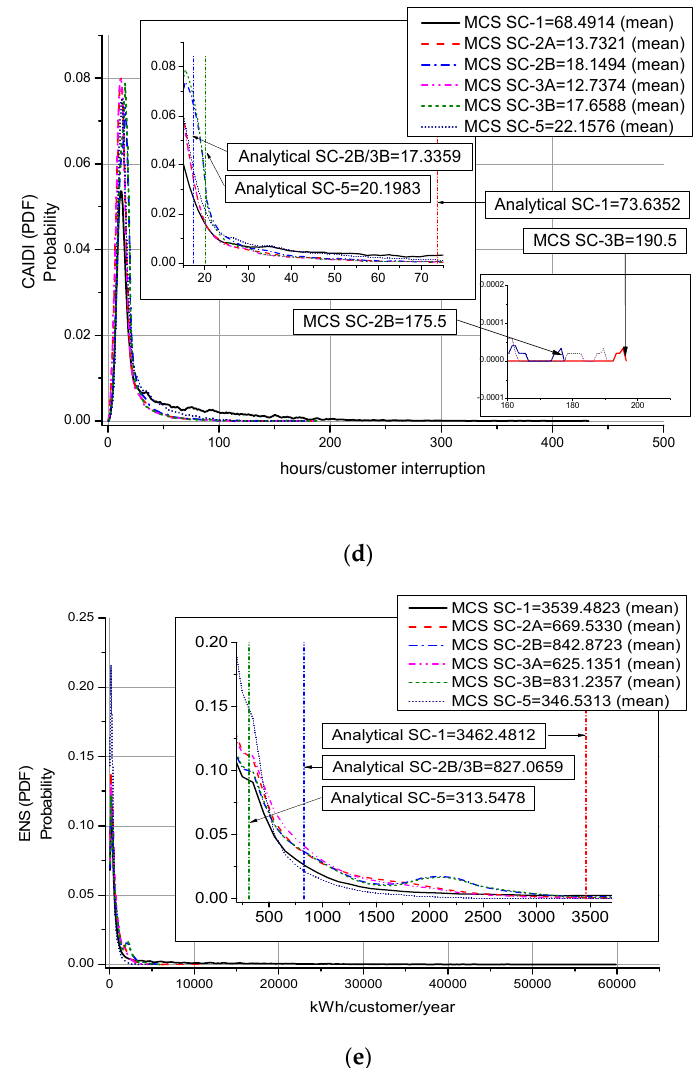
Figure 3. Indices for scenario SC-1, SC-2A/2B, SC-3A/3B and SC-5. ( a ) SAIFI index; ( b ) MAIFI index; ( c ) SAIDI index; ( d ) CAIDI index; and ( e ) ENS index.